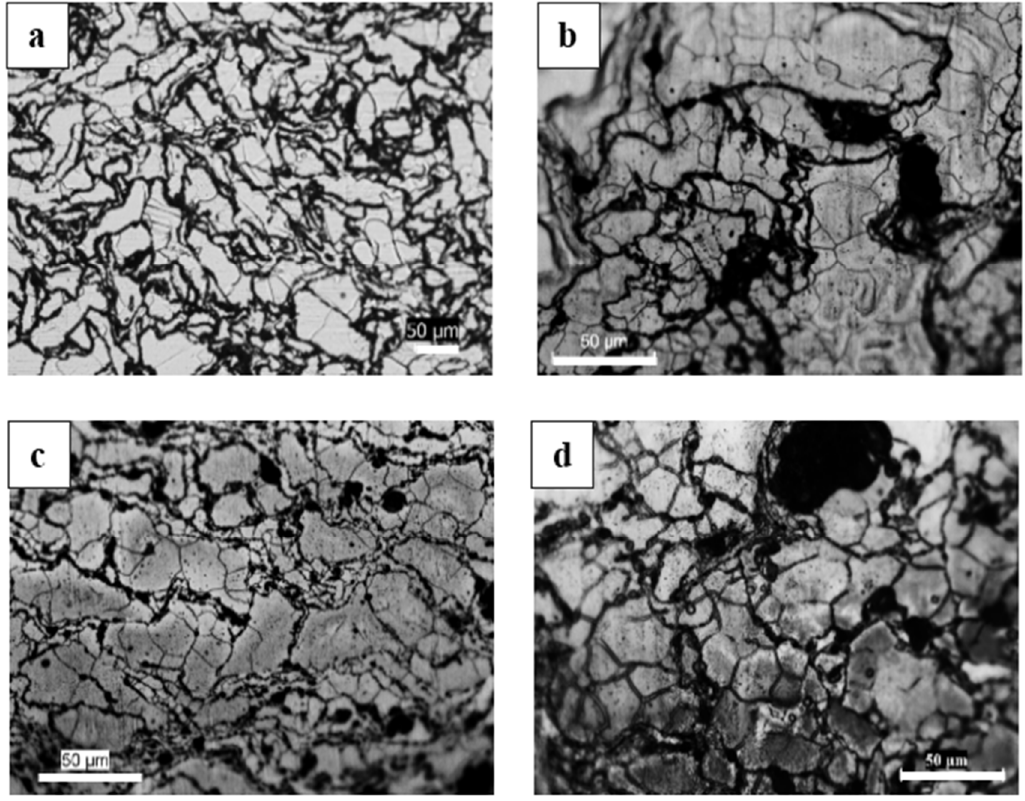
Figure 5. The grain size distribution pattern in the etched surfaces of the: ( a ) Mg; ( b ) Mg-2.5CCA; ( c ) Mg-5CCA; and ( d ) Mg-7.5CCA composites.